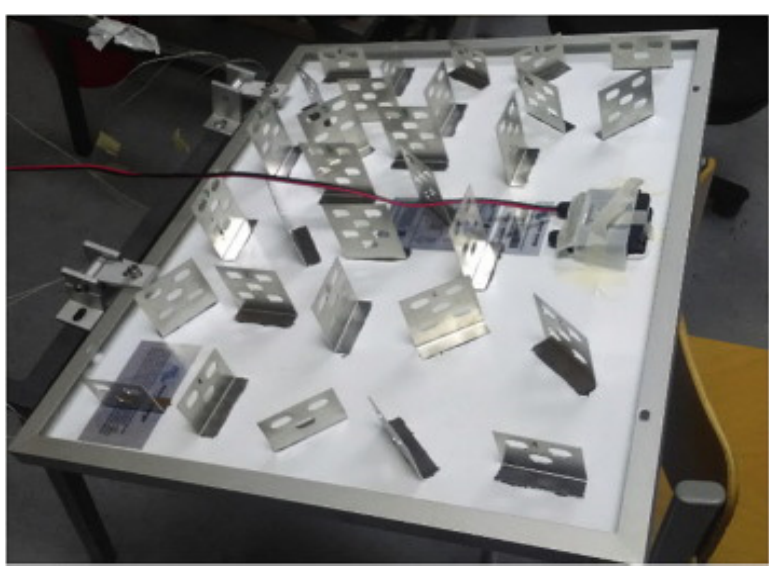
Figure 49. Heat sinks on backside of PV panel